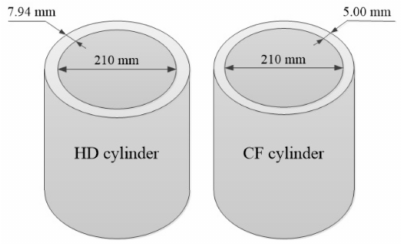
Figure 1. Gas cylinders with a diameter of 210 mm used in this work.